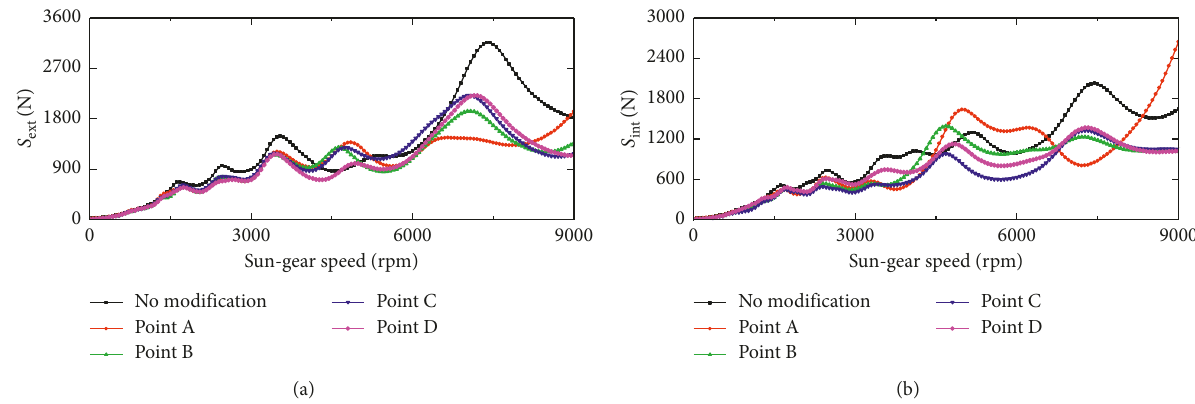
Figure 19: Dynamic tooth loads on external and internal meshes versus sun-gear speed TPM applied in internal meshes: (a) ring-planet meshes and (b) sun-planet